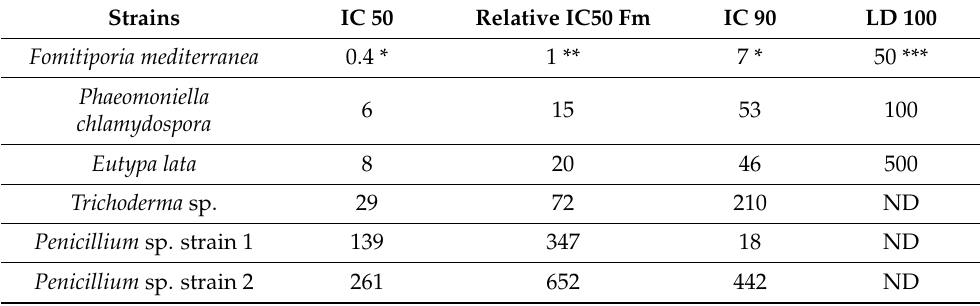
Table 5. Sensitivity of fungal species from grapevine woody tissues to sodium arsenite. Fungal strains were isolated from grapevine woody tissues (see Table S5) and cultivated on malt agar supplemented with different concentration of sodium arsenite. * Concentration (mg/L) of sodium arsenite required to inhibit fungal mycelial growth at 50% (IC 50) or 90% (IC 90). ** Relative IC50 Fm: sensitivity of fungi tested compared to F. mediterranea (IC50). *** Concentration (mg/L) of sodium arsenite required to kill fungal strains. Concentration required to kill the fungus is >500 mg/L. ND: not done. Strains IC 50 Relative IC50 Fm IC 90 LD 100 Fomitiporia mediterranea 0.4 * 1 ** 7 * 50 *** Phaeomoniella chlamydospora Eutypa lata Trichoderma sp. Penicillium sp. strain 1 139 347 ND Penicillium sp. strain 2 261 652 442